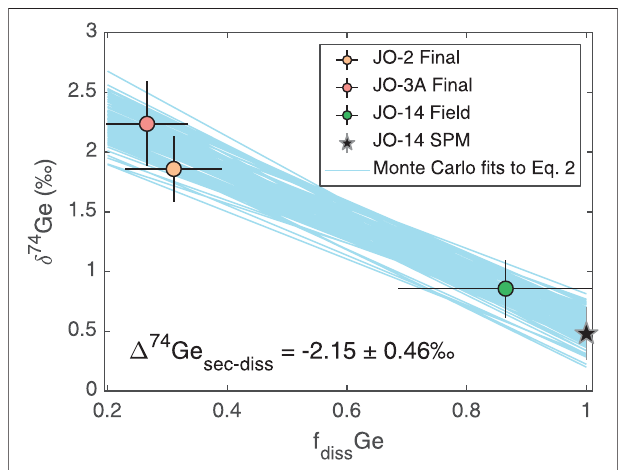
FIGURE 5 | Dissolved δ 74 Ge as a function of dissolved Ge fraction remaining in solution ( f diss Ge ) . The blue lines show 100 examples of the 10,000 Monte Carlo linear regression fi ts incorporating uncertainty in both parameters. The slopes are equivalent to the fractionation factor Δ 74 Ge sec − diss (see Eq. 2 )and thevalueshown isthe mean Carlo runs.